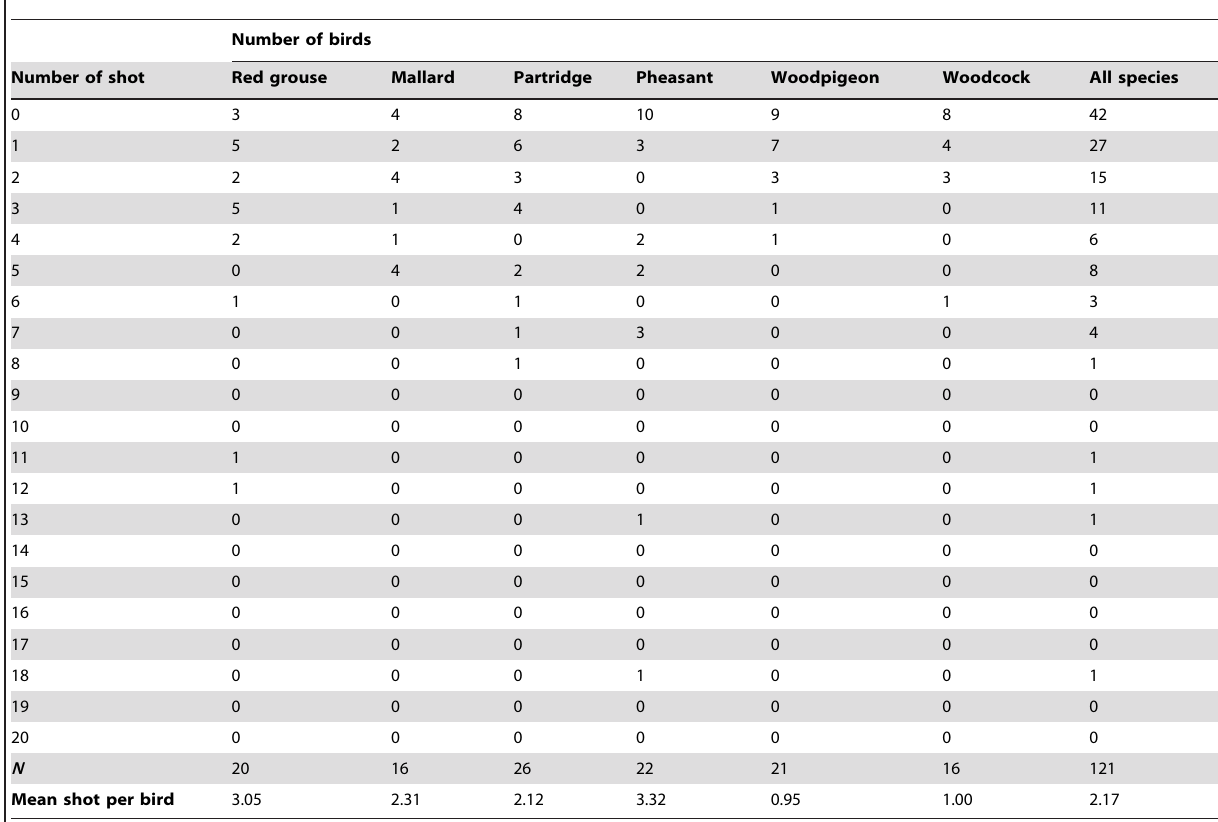
Table 1. Numbers of gamebirds recorded with various numbers of shot detectable on X-rays.